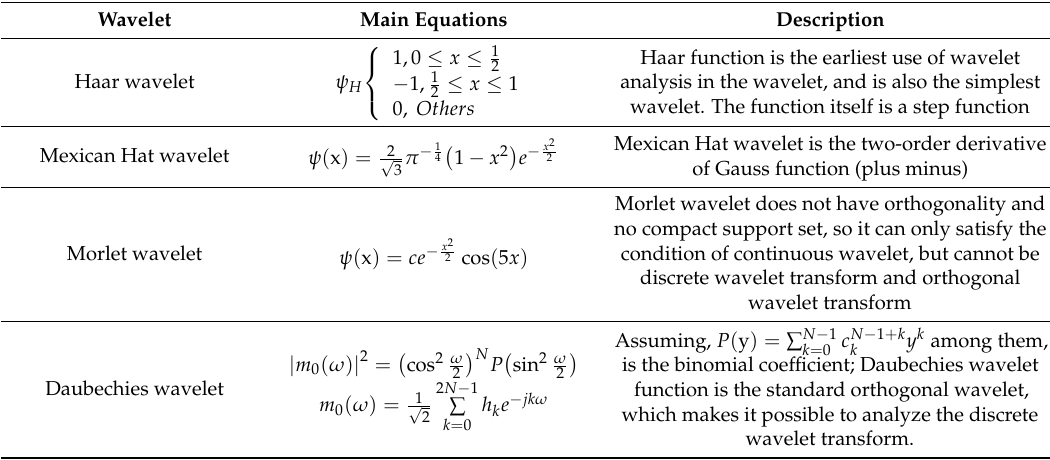
Table 11. Short summary of commonly used